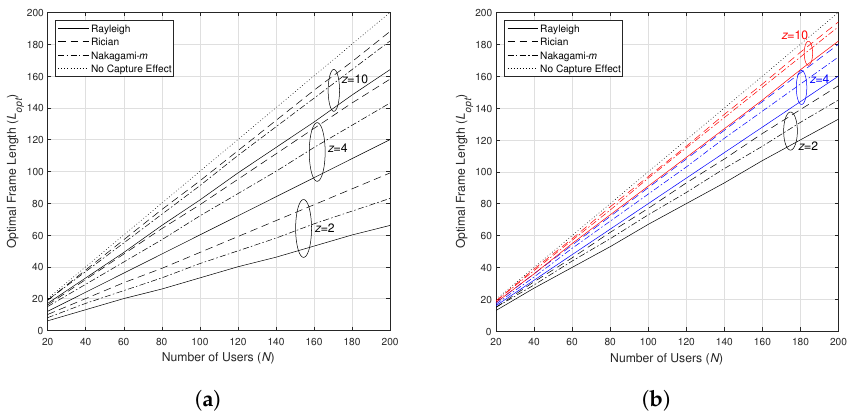
Figure 4. Optimal frame length when the capture ratio ( z ) = 2,4,10. ( a ) Assume all the collided slots are only caused by two packets; ( b ) Collided slots are caused by two or more packets in